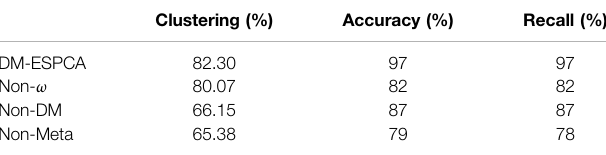
TABLE 4 | Result of the ablation